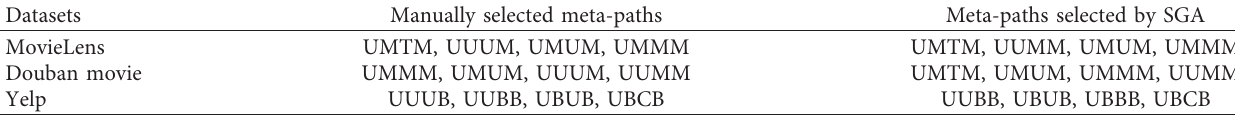
Table 2: Manually selected meta-paths and the meta-paths selected by SGA in three datasets. Datasets